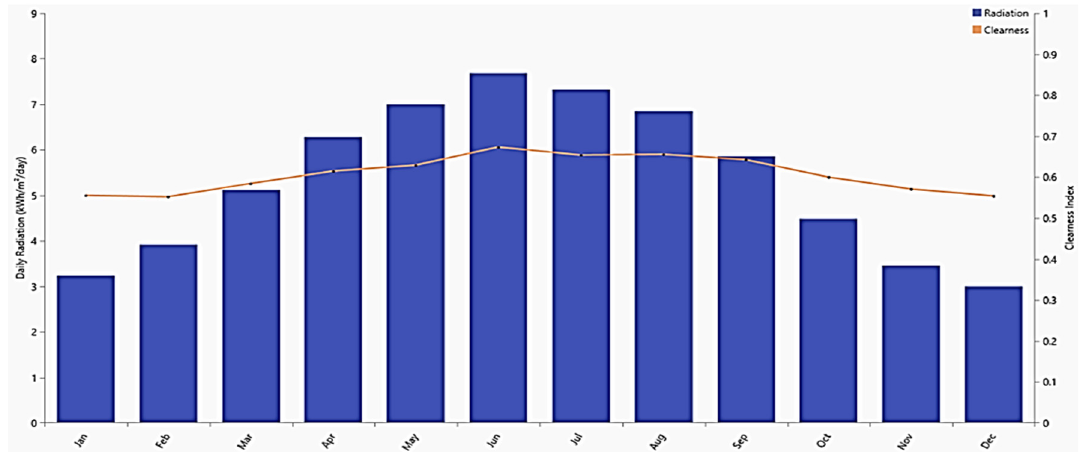
Figure 7. Solar global horizontal irradiance (GHI), Zagazig based on the input data from [24].